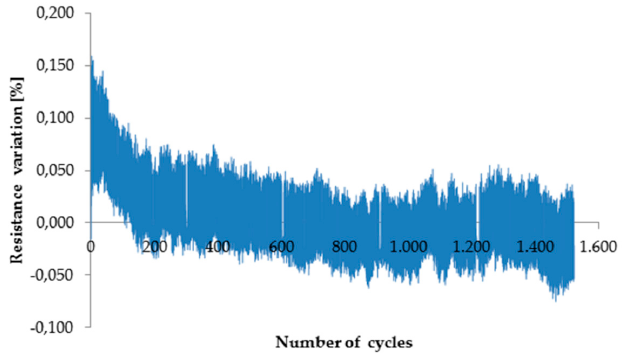
Figure 8. Testing of EPDM/PP/4 wt.% CNT composite up to 1500 cycles (displacement: 0–1.5 mm, speed: 50 mm/min).